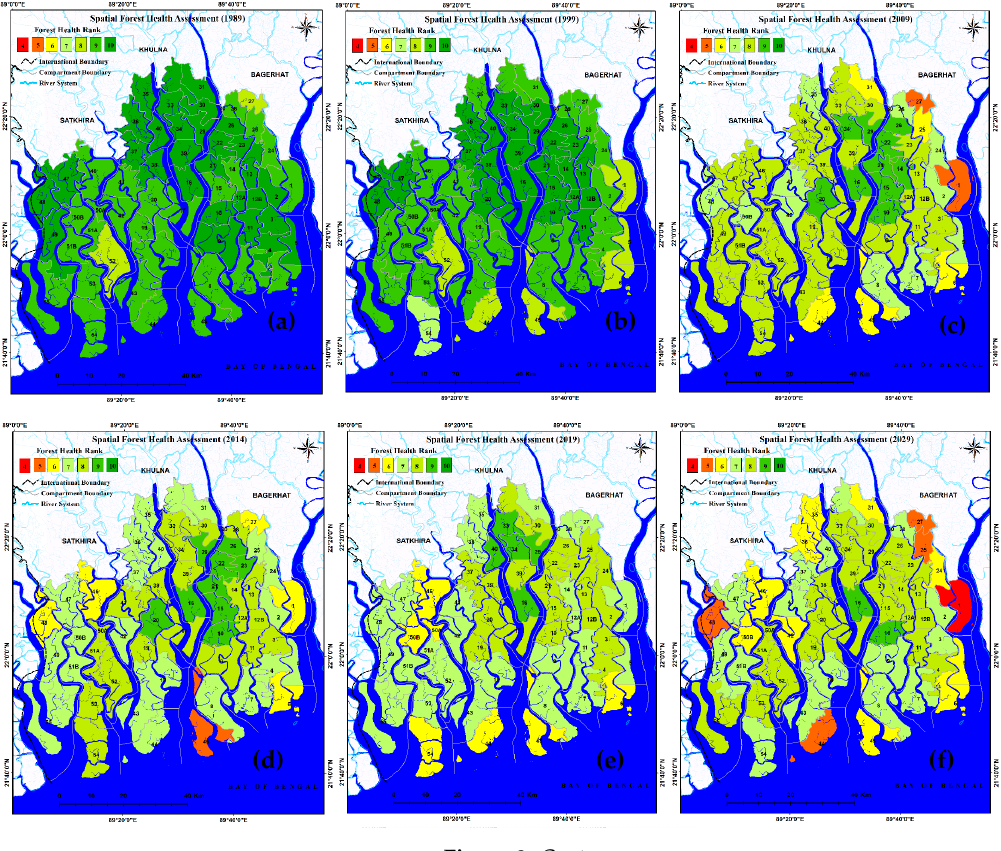
Figure 8. Spatial forest health quality assessment from 1989–2029. ( a ) SFHQ status of 1989, ( b ) SFHQ status of 1999, ( c ) SFHQ status of 2009, ( d ) SFHQ status of 2014, ( e ) SFHQ status of 2019, ( f ) future SFHQ status of 2029, ( g ) overall CGP forest in SRF (1989–2029). Note: FC numbers is labeled with black bold numbers. Figure 8a–e represent the earlier SFHQ of SRF, whereas Figure 8f,g represent future forest quality and CGF status. The SFHQ values by the number of forest compartment are represented by Figure 9. In 1989, a total of 30 and 26 forest compartments were in good quality, representing 95– 100% and 85–94% of TR and HE, compared to the 2019 status, which had five forest